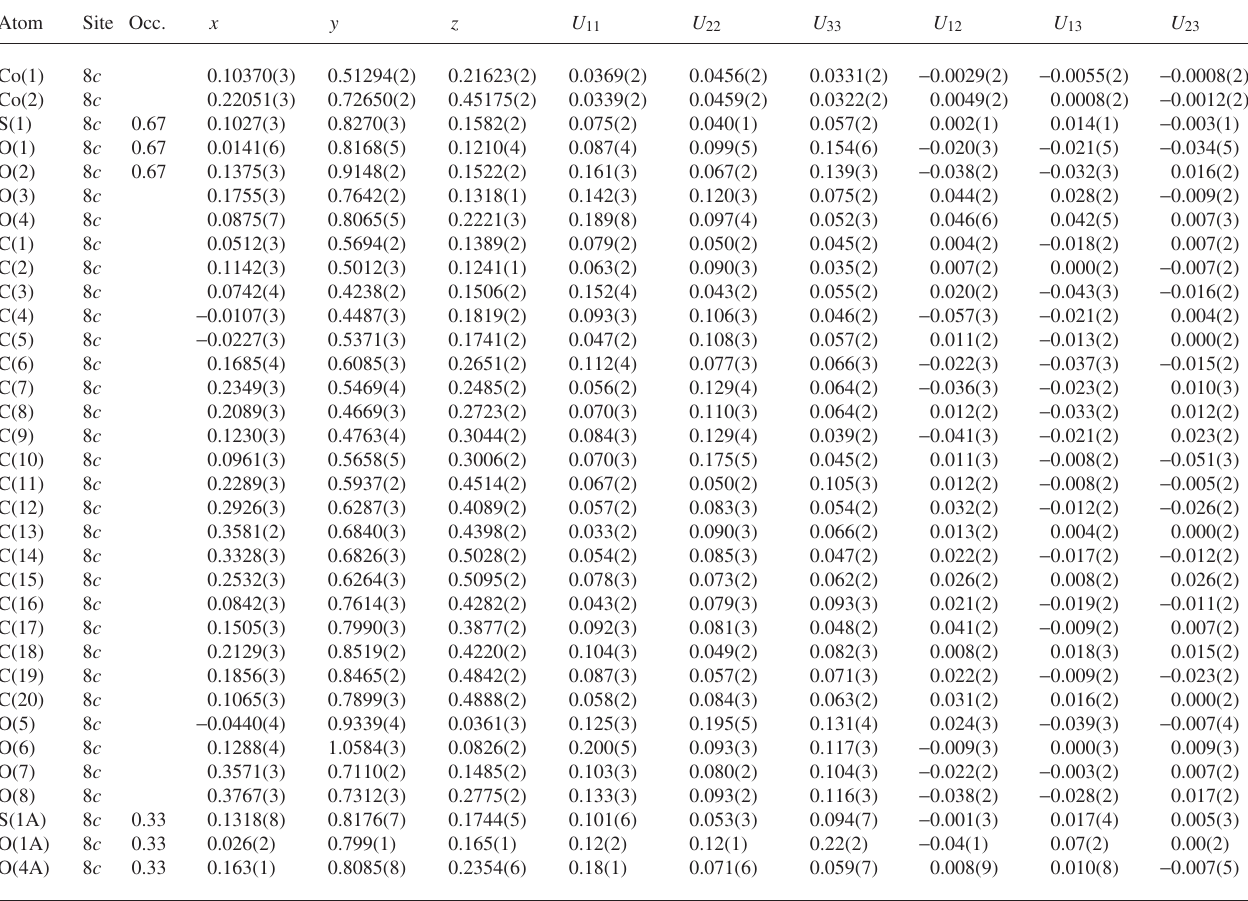
Table 3. Atomic coordinates and displacement parameters (in Å 2 ) . Atom Site